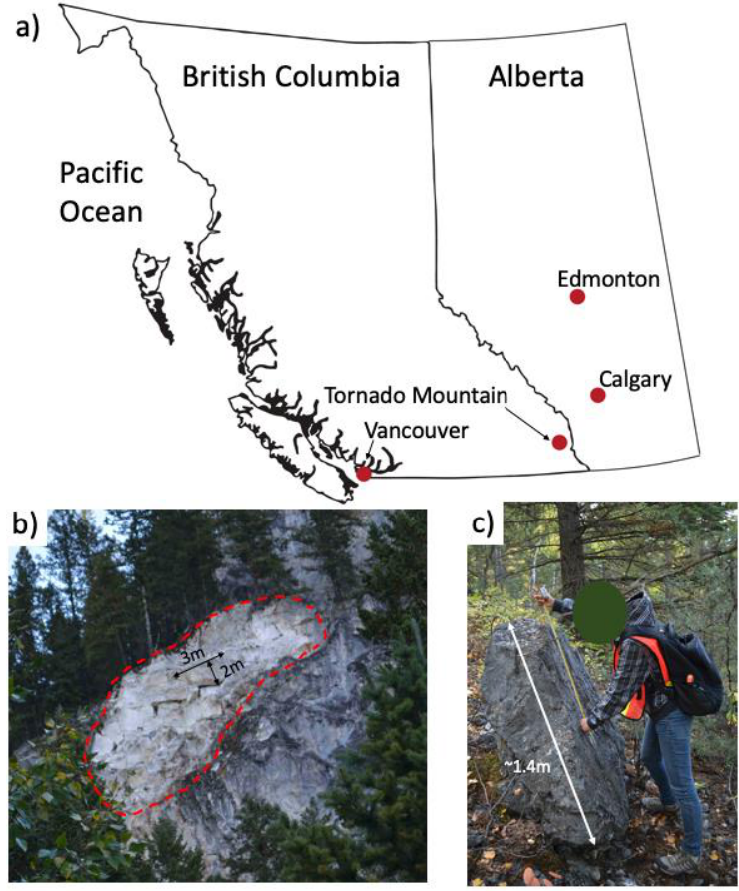
Figure 2. Location of Tornado Mountain ( a ), view of the source of the 2004 rockfalls ( b ), and example of blocks encountered within the rockfall paths during surveying ( c ).